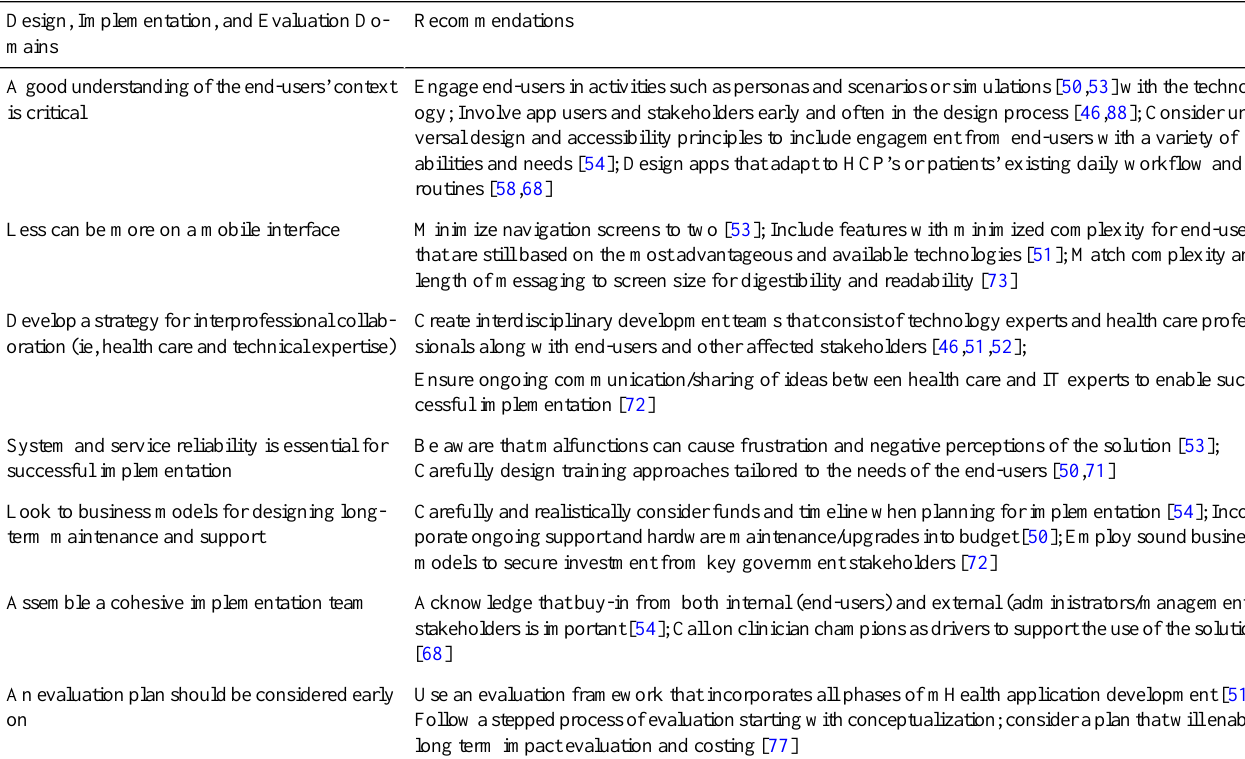
Table 3. Lessons learned in designing, implementing, and evaluating mHealth to support older adults with chronic conditions at home. RecommendationsDesign, Implementation, and Evaluation